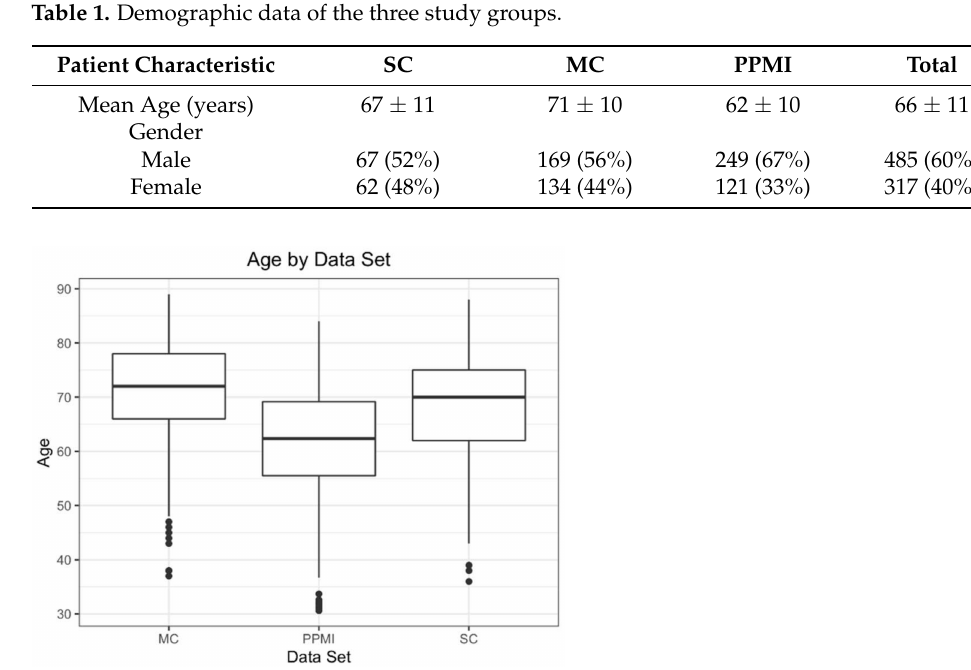
Figure 2. Box and whisker plots for all three data sets.